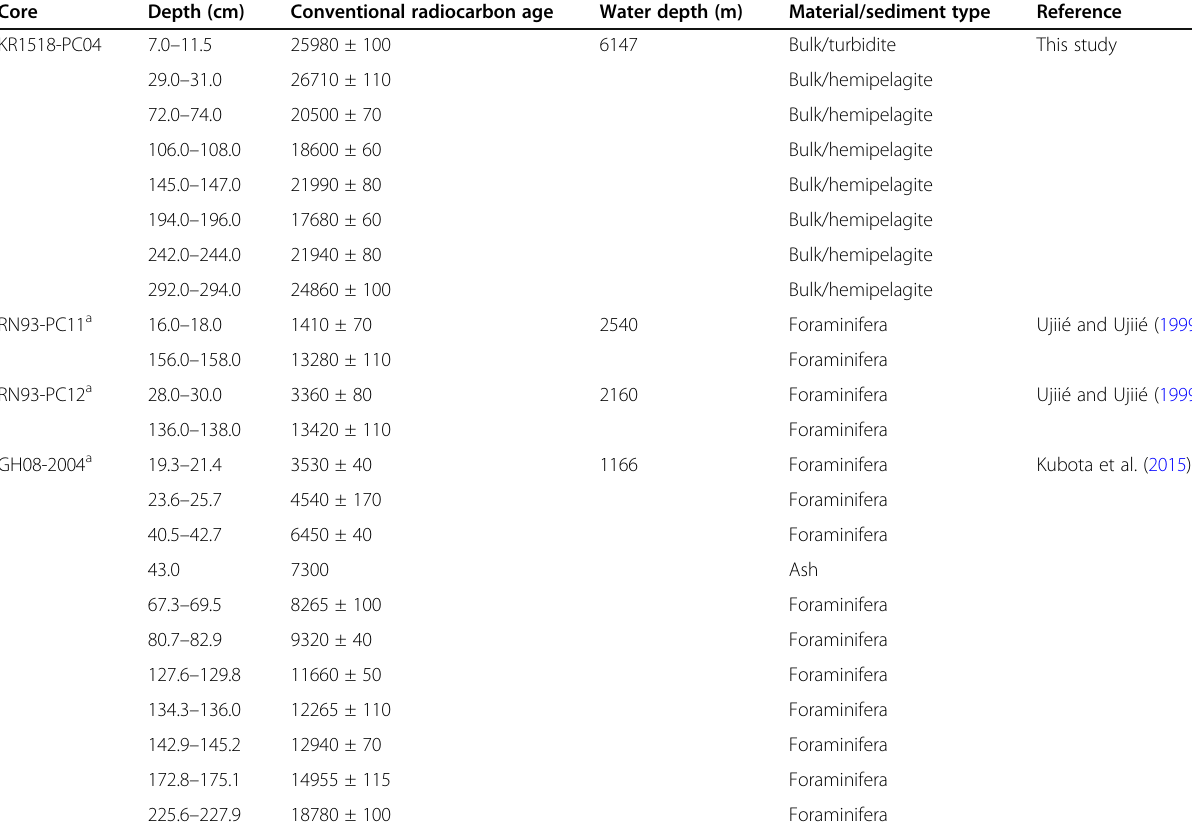
Table 2 Radiocarbon ages from core PC04 compared to previous age results from the Ryukyu Arc Core